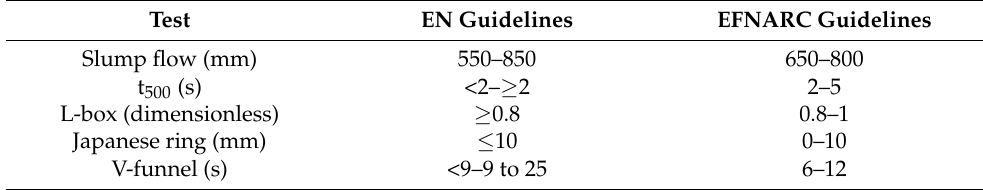
Table 4. EN and EFNARC guidelines.